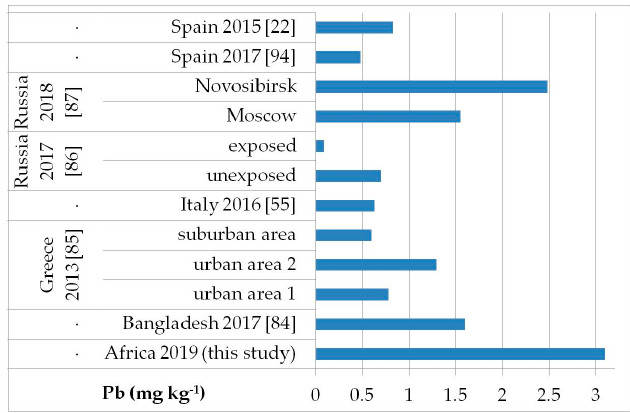
Figure 4. Comparison of the Hg concentrations in children’s hair (as geometric mean; mg kg − 1 ) found in our study and other biomonitoring studies.